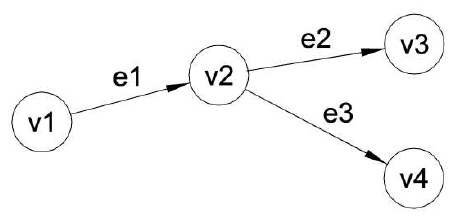
Figure 1. Tree structure of a simple